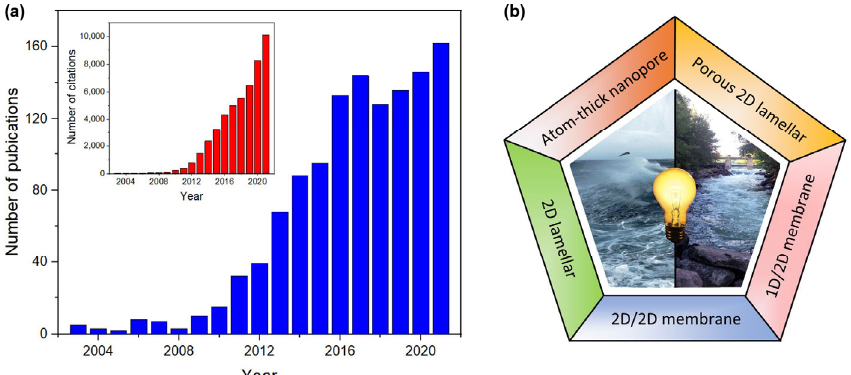
Figure 1 The numbers of publications and citations (inset) in the field of osmotic power generation from 2003 till 2021. The topic keywords were set to (“osmotic power generation” or “salinity gradient power generation”), obtained from ISI Web of Science, March 2022 (a). Several types of two-dimensional membranes for salinity gradient power generation are reviewed in this paper